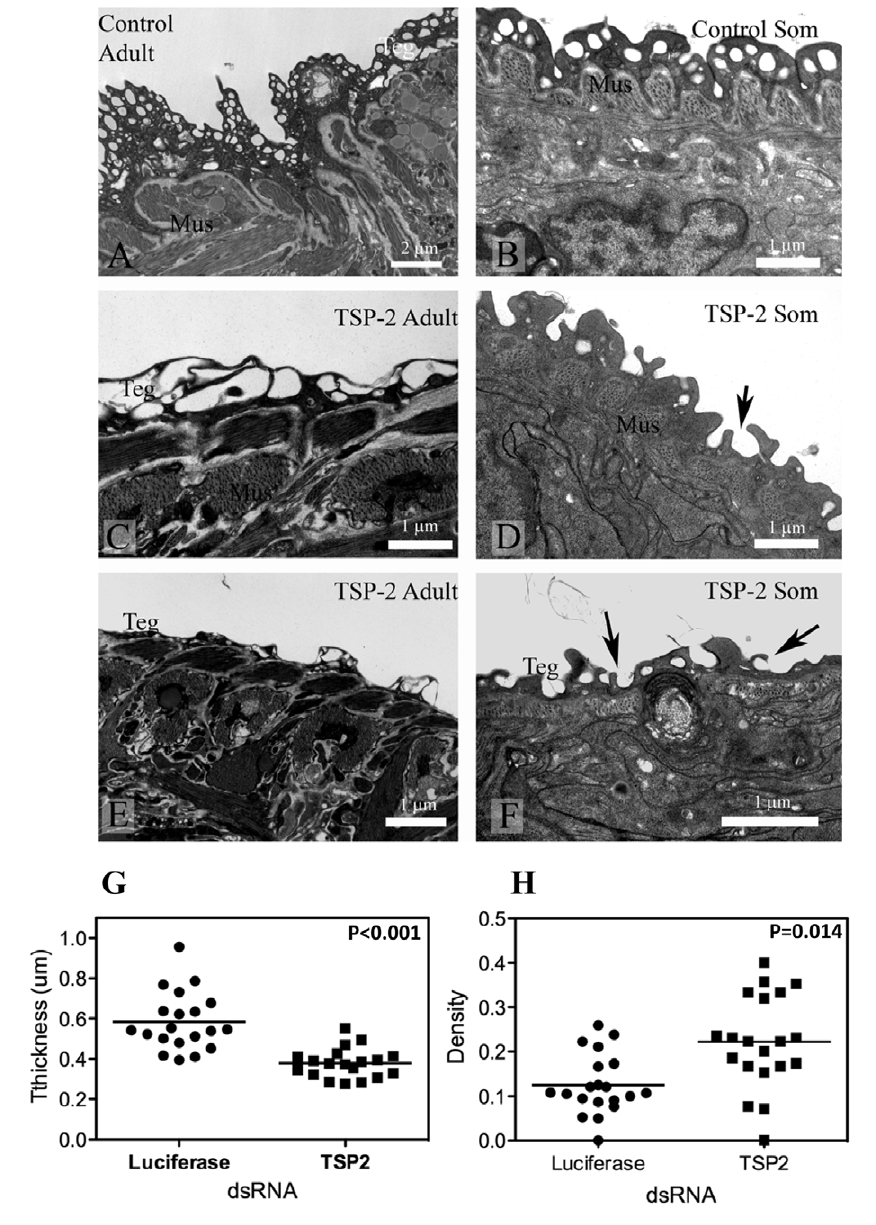
Figure 6. Ultrastructure of the tegument of parasites treated with Sm-tsp-2 dsRNA RNA observed using transmission electron microscopy. A. Tegument of adult female treated with luciferase dsRNA. B. Tegument of schistosomulum incubated for 7 days with luciferase dsRNA. C and E. Tegument of adult female incubated with Sm-tsp-2 dsRNA. The tegument is more highly vacuolated (C) and thinner (E) compared with controls. D and F. Tegument of schistosomula incubated for 7 days with Sm-tsp-2 dsRNA. Digitate extensions (arrows) are more abundant on the surface of the tegument. Abbreviations: Mus-muscles; teg-surface layer of tegument. The tegument of schistosomula were thinner, p , 0.001 (G) and more dense, p=0.014 (H) in Sm-tsp-2 dsRNA treated schistosomula.